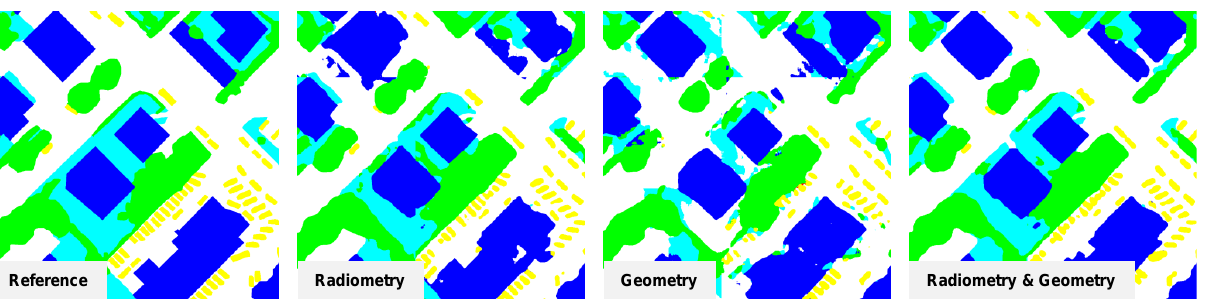
Figure 6. Visualization of the reference labeling and the results for semantic segmentation when using only radiometric features, when using only geometric features and when using both geometric and radiometric features (from left to right): the color encoding addresses the classes Impervious Surfaces (white), Building (blue), Low Vegetation (cyan), Tree (green) and Car (yellow).